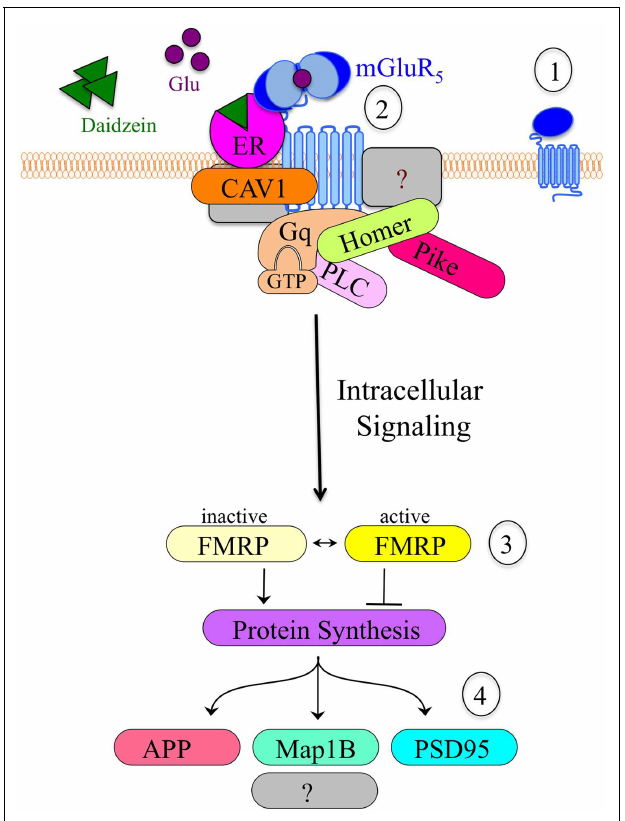
FIGURE 2 | Model of the hypothetical estrogen-induced signaling pathway in neurons . (1) mGluR 5 is a primary target for drug development in FXS. (2) Cell stimulation causes clustering of mGluR 5 receptors and altered interactions with scaffolding proteins such as ER, caveolin and Homer, which likely alter downstream signaling events. Daidzein or other estrogenic compounds act as ER agonists. (3) mGluR 5 is known to signal through FMRP, a translational repressor.The absence of FMRP in Fmr1 KO cells results in constitutive, unregulated protein synthesis in response to mGluR 5 stimulation. (4) Altered mGluR 5 /FMRP signaling modulates the synthesis of numerous synaptic proteins including APP, microtubule-associated protein 1B (Map1B), and postsynaptic density protein 95 (PSD95). Excessive production and accumulation of these synaptic proteins contributes to elevated epileptiform activity and FXS